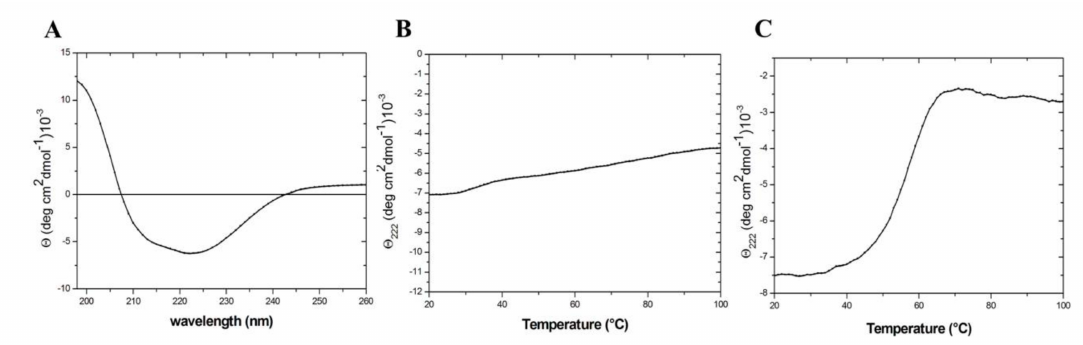
Figure 5. Spectroscopic characterization of D1 F57W : Far-UV CD spectrum ( A ), thermal denaturation curves in PBS bu ff er ( B ) and in PBS bu ff er containing 4.0 M GuHCl ( C